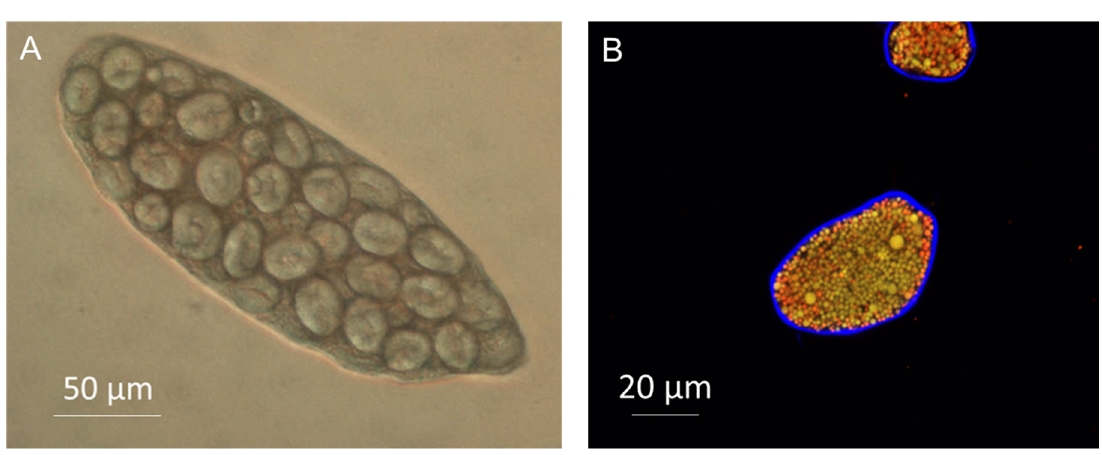
Figure 2. Light microscopy image of chickpea ( A ) and confocal image of almond ( B ) cells. Note the cell wall surrounding the cell full of starch ( A ) or lipid and protein bodies ( B , cell wall stained in blue with Calcofluor White and lipid in red with Nile Red).